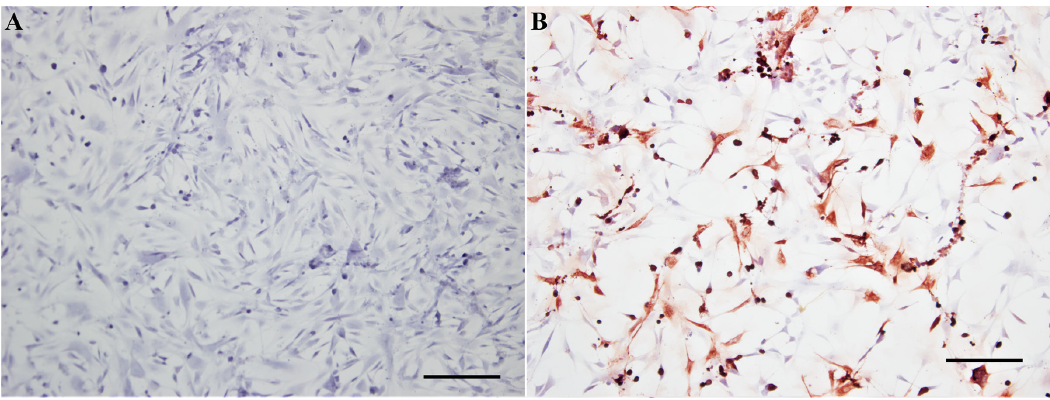
Figure 10. Immunohistochemical staining of USUV antigens performed on chicken chorioallantoic membrane cells. ( A ) Mock-inoculated cells; ( B ) USUV-infected cells. Mayer hematoxylin counterstain. Scale bars = 50 µ